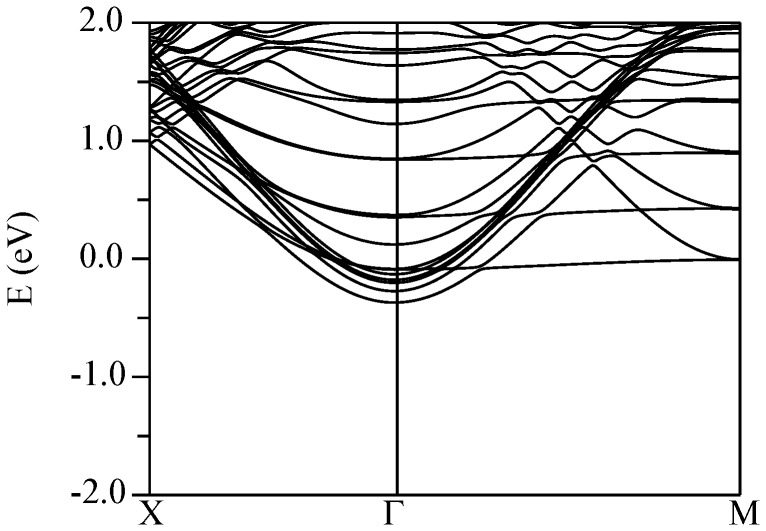
Calculated conduction band structure of the relaxed (KNbO3)//(CaSnO3) supercell (see text) using the TB-mBJ potential.The Fermi energy is at 0 eV.